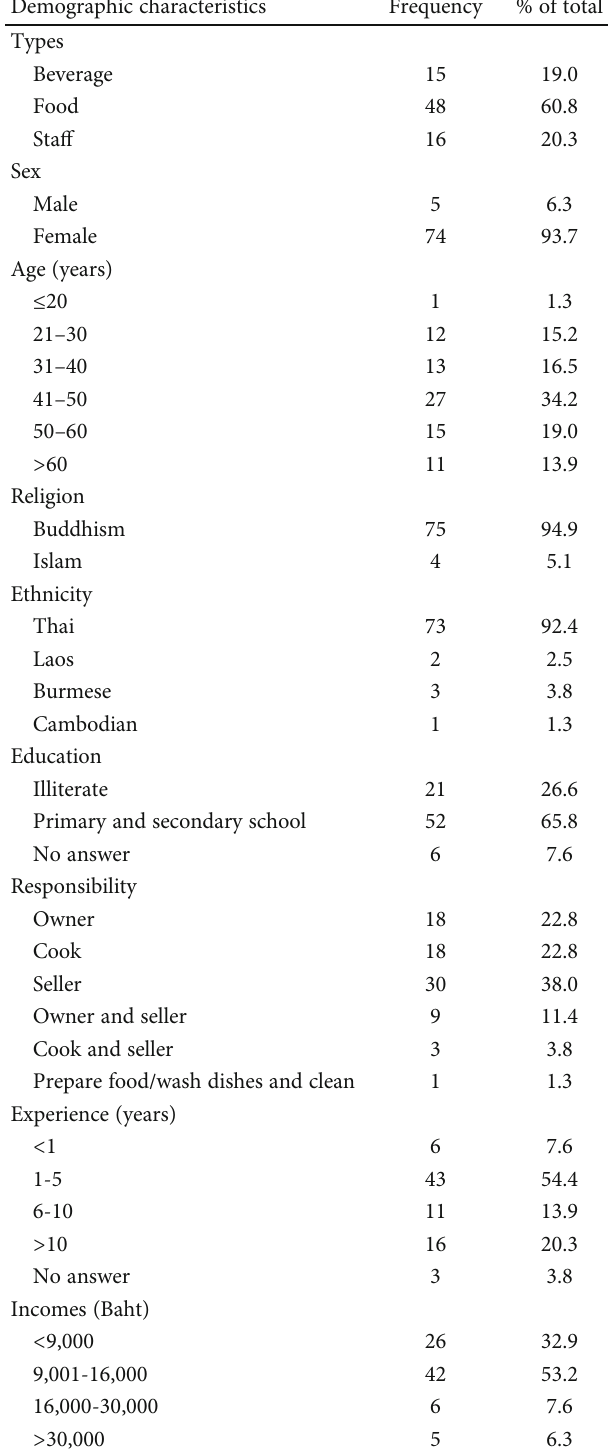
Table 1: Sociodemographic data of food handlers in RSU student canteens ( n = 79